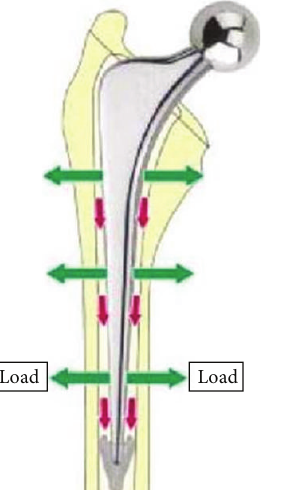
Figure 9: We used a cemented polished tapered stem transmitted load to the laudable distal part of the